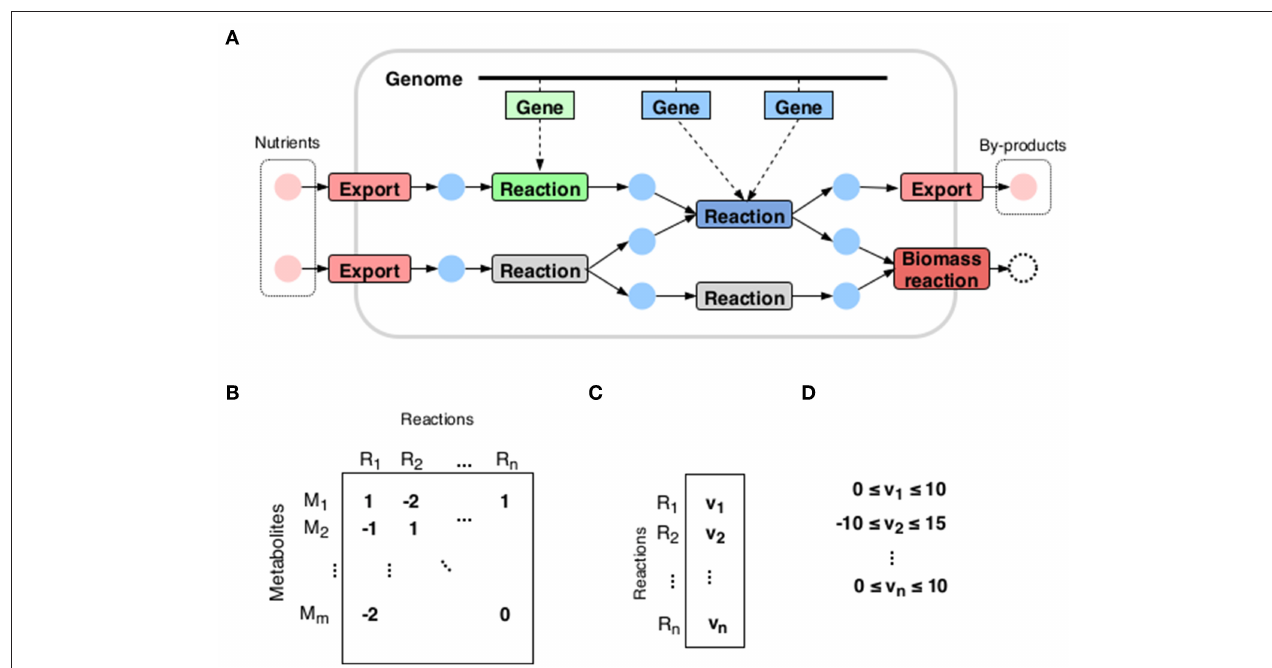
FIGURE 1 | A metabolic reconstruction. (A) A metabolic network is constructed by joining together reactions whose enzymes are recognized in the organism’s genome. (B) The most commonly used mathematical representation is the stoichiometric matrix : its rows correspond to the metabolites of the network and columns to reactions. The entries are stoichiometric coefficients: how much of the metabolite is consumed or produced in the reaction. (C) The flux vector expresses the state of the metabolism: its entries correspond to reaction rates. (D) Each reaction rate has a lower and an upper